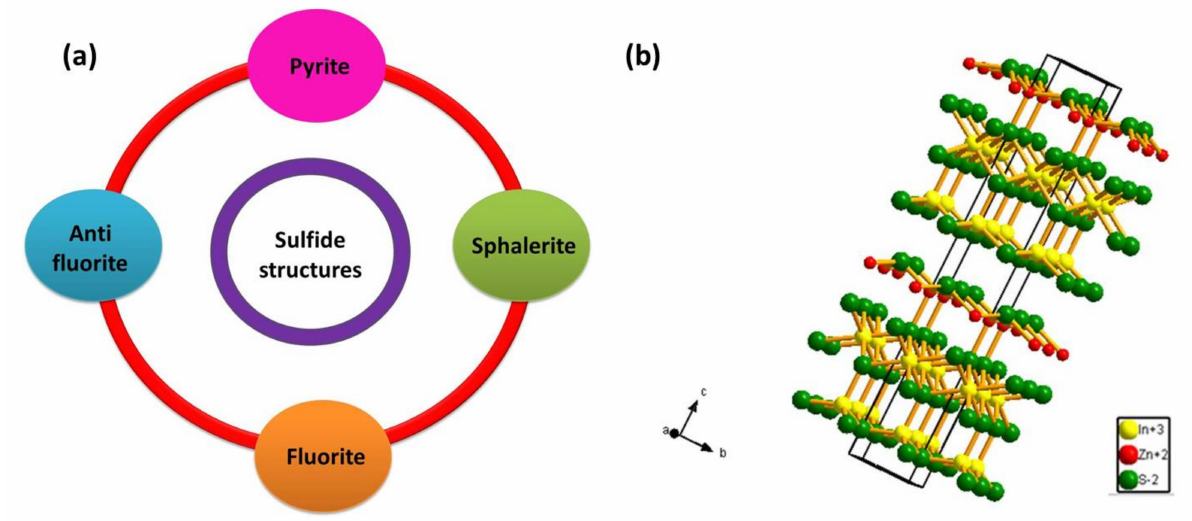
Figure 1. ( a ) Classification of sulfide compounds based on their structure. ( b ) The layered hexagonal structure of ZnIn 2 S